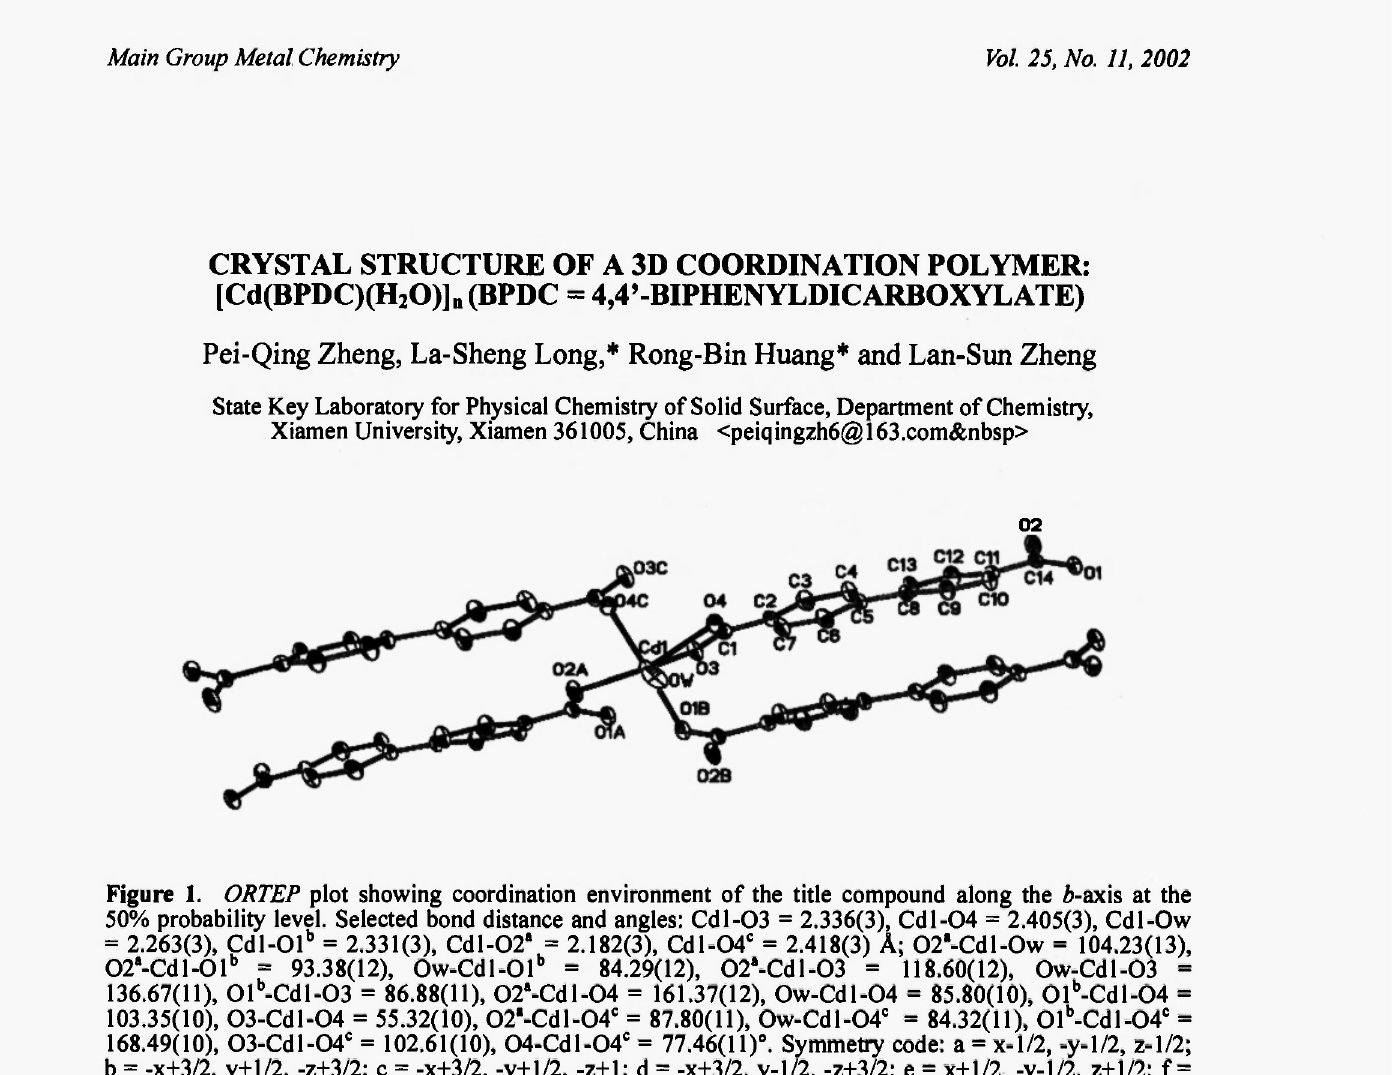
b = -x+3/2, y+1/2, -z+3/2; c = -x+3/2, -y+1/2, -z+1; d = -x+3/2, y-1/2, -z+3/2; e = x+1/2, -y-1/2, z+1/2; f = x, y+1, z; g = x-1/2, -y+1/2,